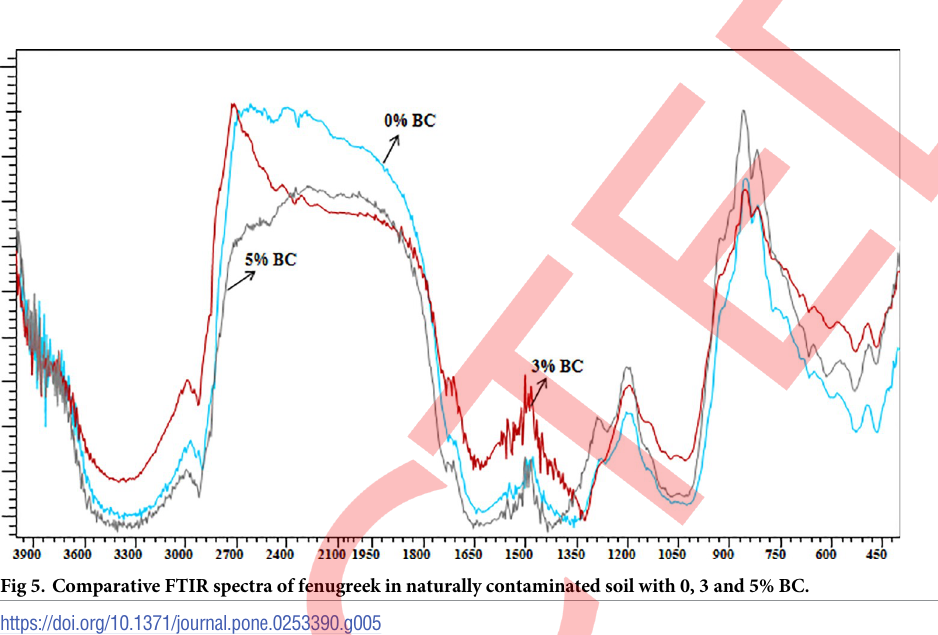
Fig 5. Comparative FTIR spectra of fenugreek in naturally contaminated soil with 0, 3 and 5% BC.